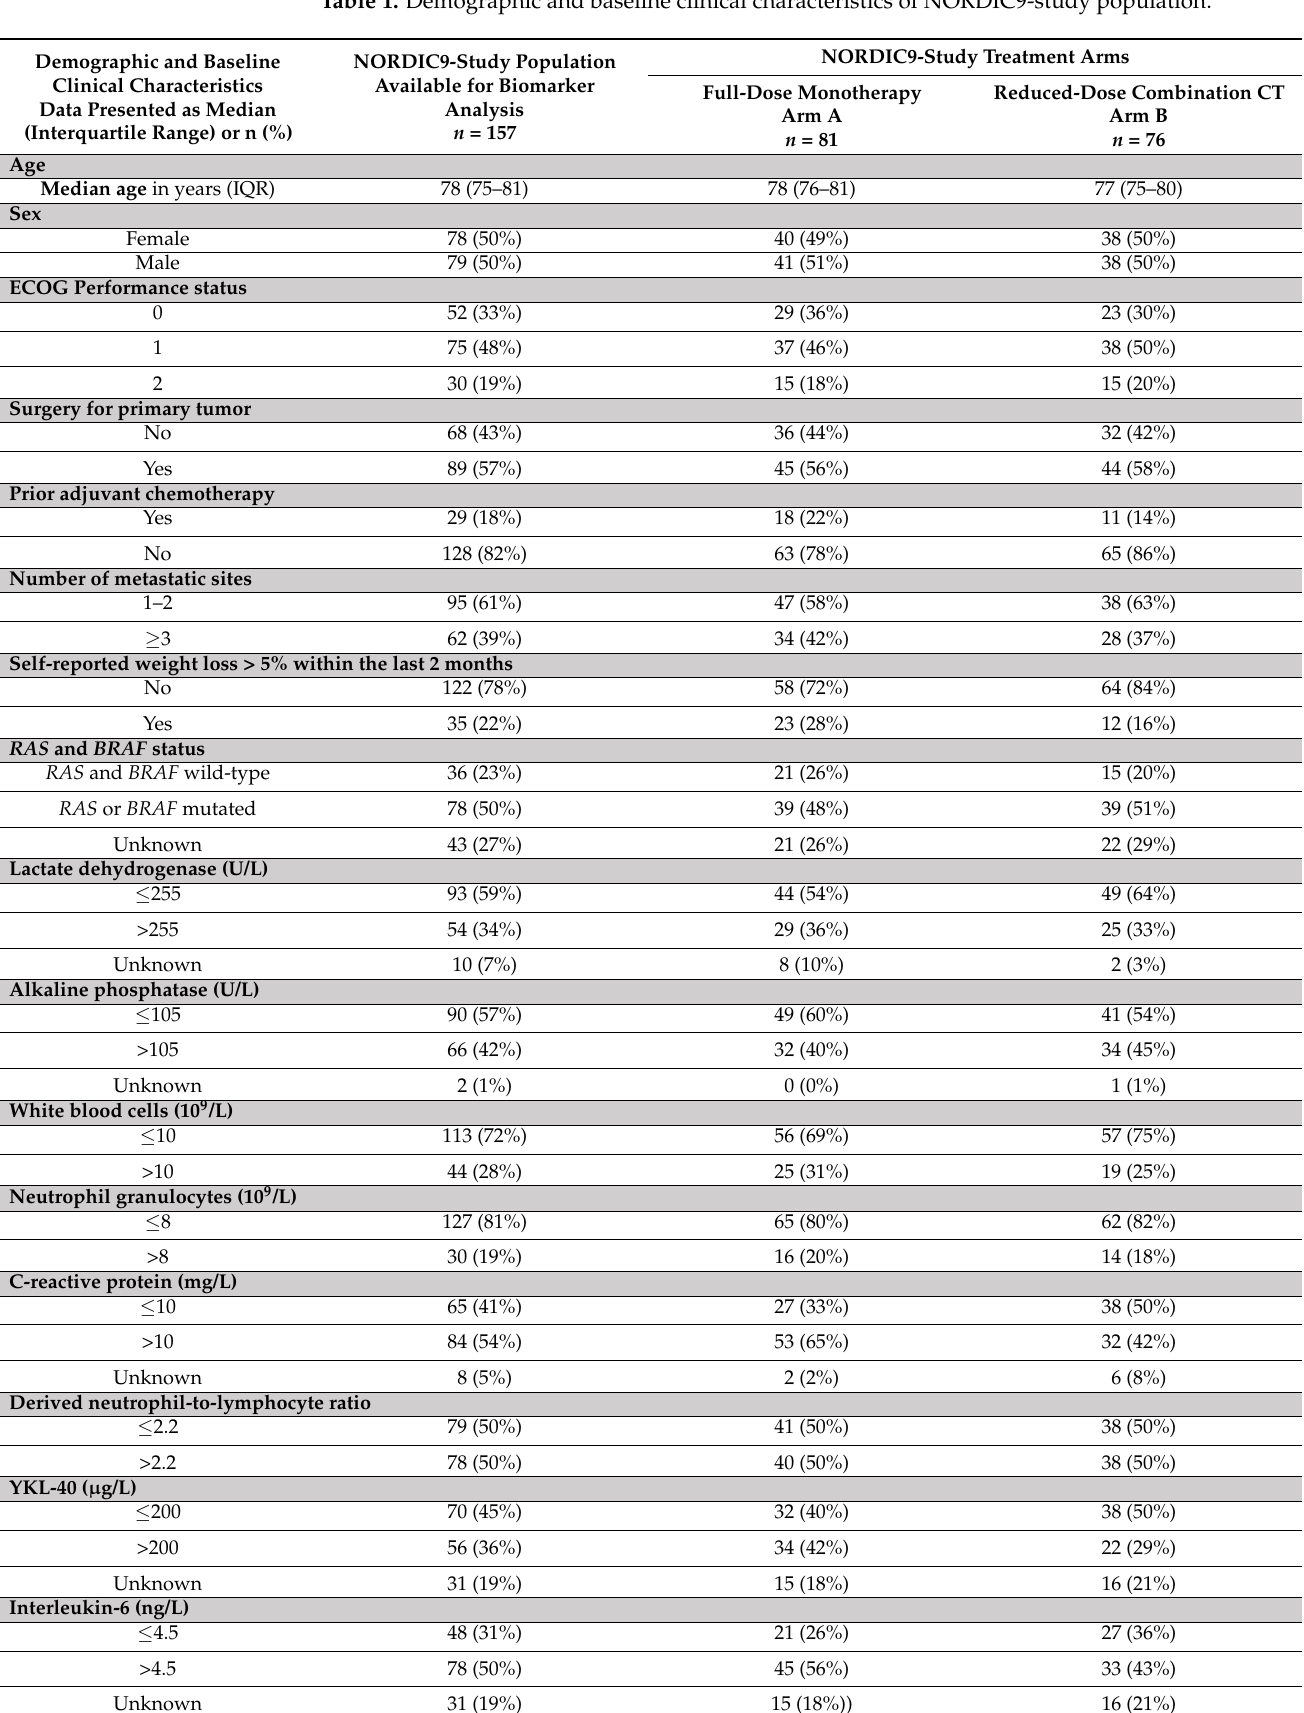
Table 1. Demographic and baseline clinical characteristics of NORDIC9-study